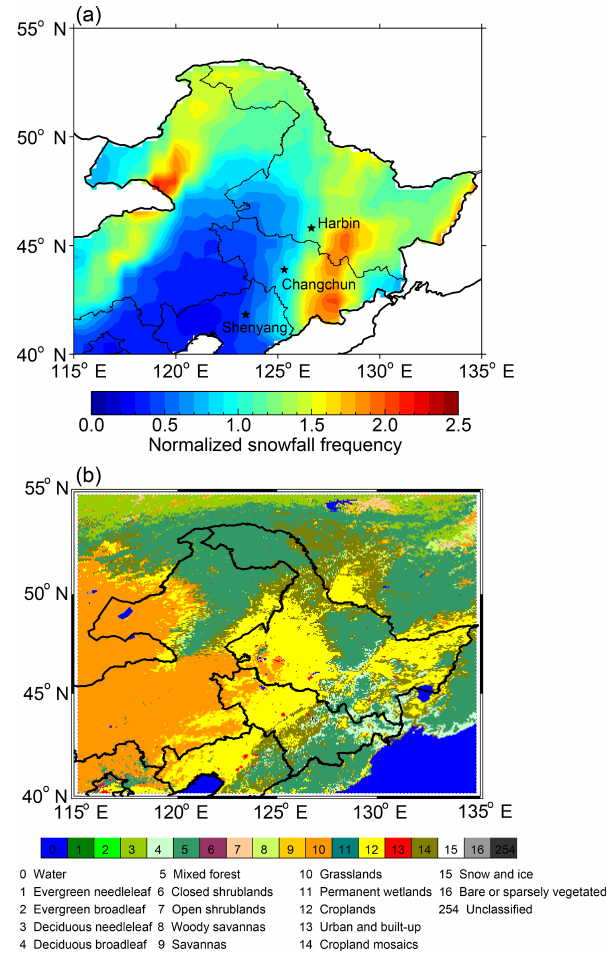
Figure 3. Spatial distribution of (a) the normalized snowfall fre- quency in January–February from 2003 to 2017 and (b) the differ- ent land cover types based on MODIS data in NEC. Snowfall data are from the ERA-Interim reanalysis. The major cities in NEC are also shown in this